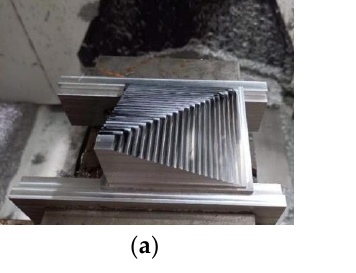
( c ) Figure 16. Test piece measurement results. ( a ) δ x. ( b ) δ y. ( c ) δ z. 6. Conclusions In this paper, a real-time thermal error compensation method of a ball screw feed system is proposed. A new iterative prediction method of the machine tool’s screw ther- mal error based on a finite difference equation is developed. Compared with the existing method of screw thermal error prediction, the proposed method in this paper has a better calculation efficiency while ensuring accuracy. The real-time compensation function of the screw thermal error based on the above method is integrated into the CNC system. A simple measurement verification experiment shows that the compensation func- tion can reduce the screw thermal error of the feed axis to within 10 µm. A comparative analysis of a test piece, machined with and without compensation, resulted in a reduction of the maximum machining error from 71 µm to 13 µm after compensation, which verifies the efficacy of the proposed screw thermal error prediction method and compensation function. The proposed model overcomes some of the challenges of traditional error com- pensation models, including high computational expense and difficult parameter identi- fication. Currently, our work is based on the no-load or light load of the machine tool. The future research will focus on the influence of complex load on the thermal error of the lead screw and consider the research through the electronic control data in the processing pro- cess.